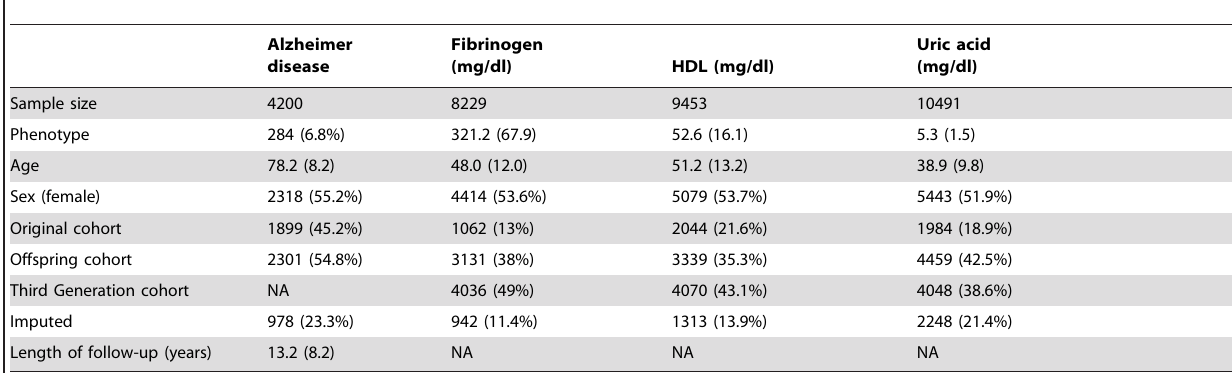
Table 5. Sample characteristics of Alzheimer disease, fibrinogen, HDL and uric acid data in the genotyped and imputed